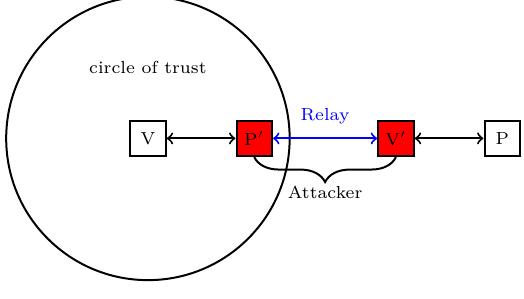
Figure 7: Relay attack on a distance bounding